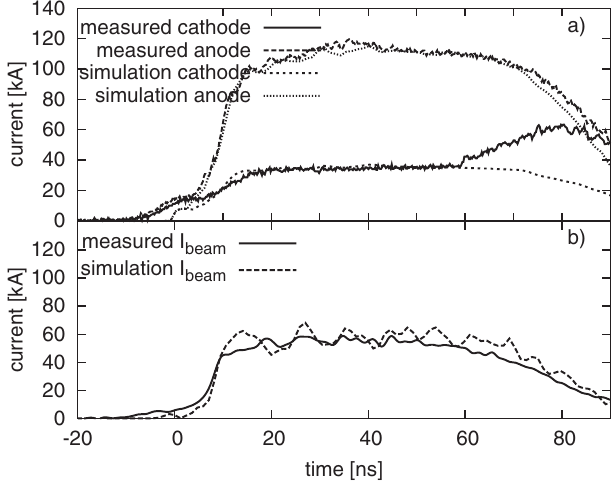
FIG. 15. Currents for the dustbin/knob configuration with the conical cathode transition of Fig. 14 attached. The load is a large-area diode with an 18-cm A-K gap. Currents at position F from simulation and data (RITS-6 shot 104) are compared in plot location in Fig. 2(b) and compared in (a). Currents from the I beam plot (b).